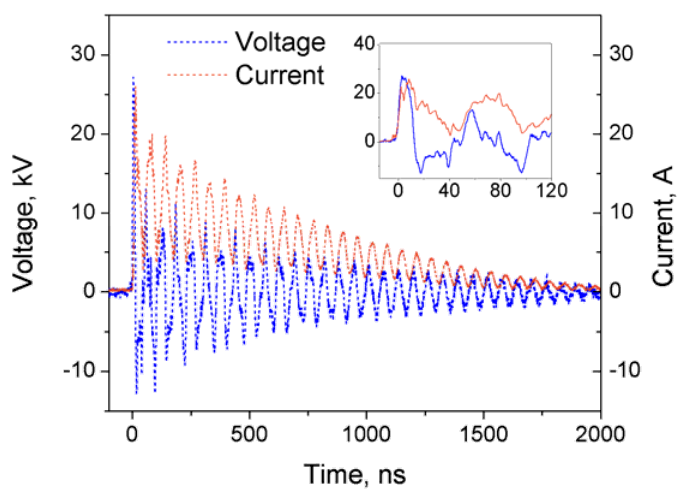
Figure 1. Current and voltage waveforms of spark discharge plasma ignited in liquid nitrogen.